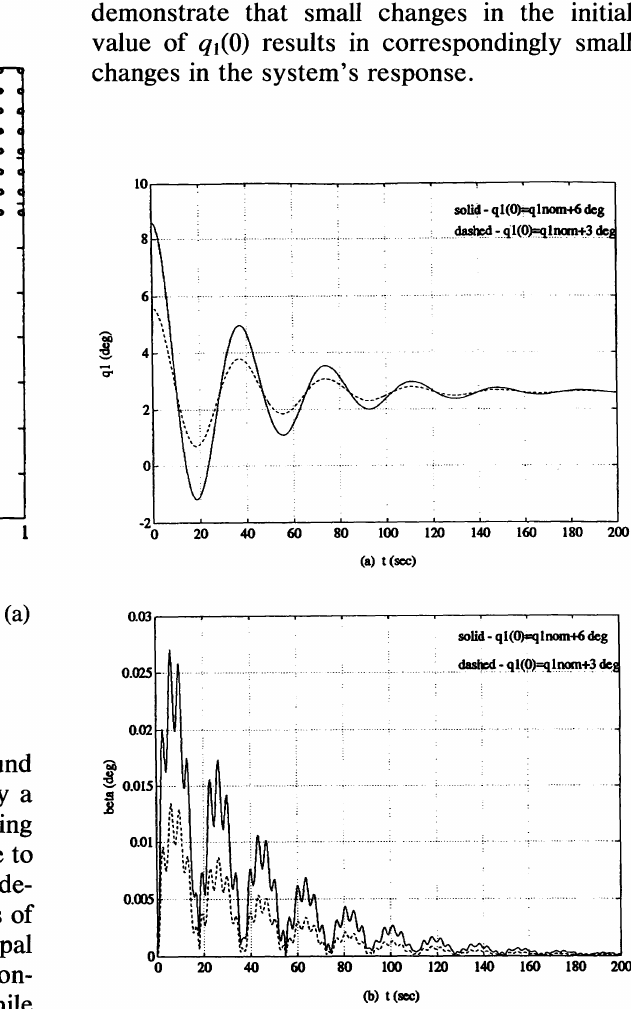
FIGURE 11 Simulation results for a system with off axis attachment. (a) q, (deg), and (b) f3